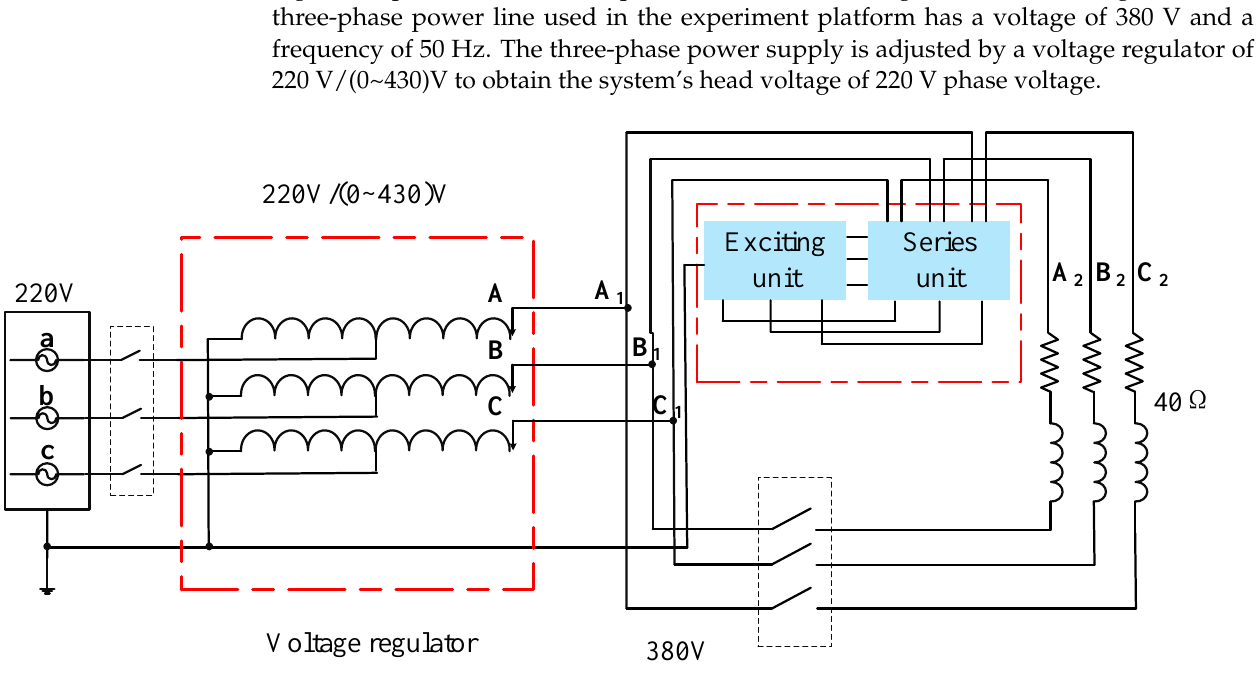
oscilloscope Voltage regulator Figure 19. Experimental wiring diagram.